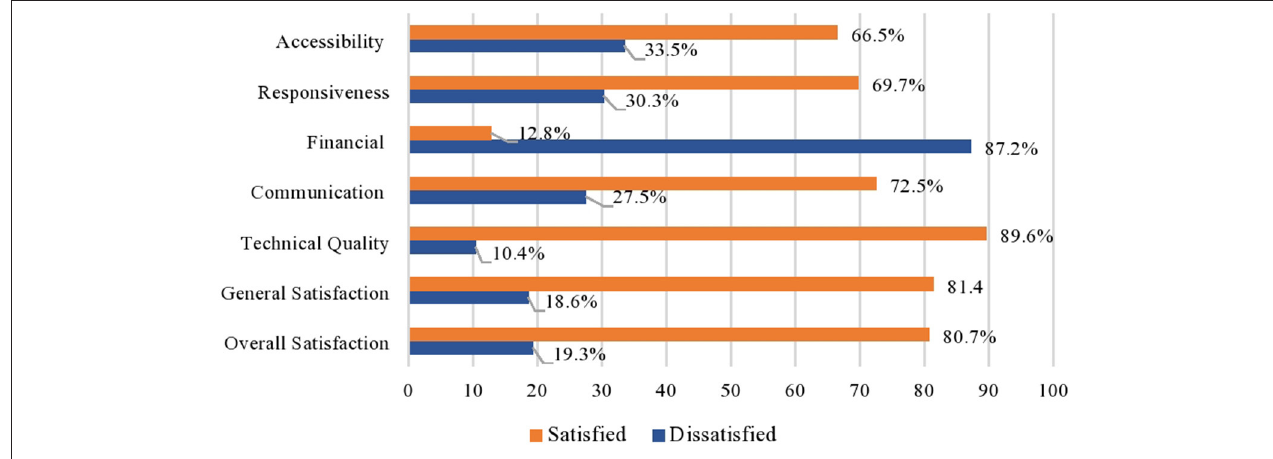
FIGURE 2 | Levels of satisfaction of postnatal mothers with skilled